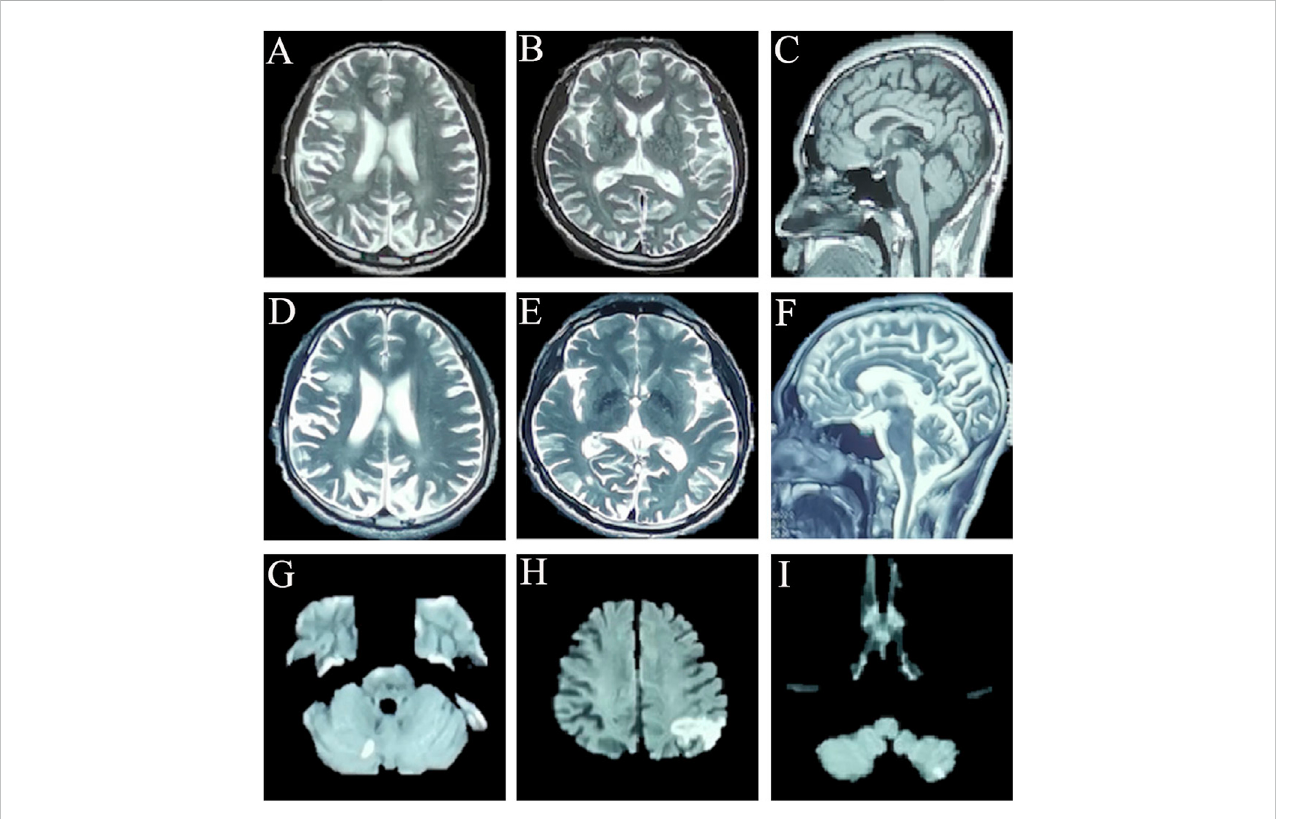
FIGURE 1 Cranial magnetic resonance imaging of this patient: (A – C) cross-sectional sequences of T2-weighted image (T2WI) (A,B) and sagittal image of T1- weighted image (T1WI) (C) (17 December 2019) showed the encephalomalacia in the right basal ganglia, frontal lobe and cerebral atrophy. (D – F) Cross- sectional sequences and sagittal images of T2WI (31 August 2021) showed that encephalomalacia foci had expanded to bilateral frontal lobe, right insula, and right temporo-occipital junction; brain atrophy is more worse than before. (G) Diffusion-weighted imaging (DWI) sequence showed punctate hyperintensity singals on the right cerebellum (22 September 2021). (H,I) DWI sequences showed abnormally high signal intensity on left parietal-occipital junction, and the left cerebellum (10 October